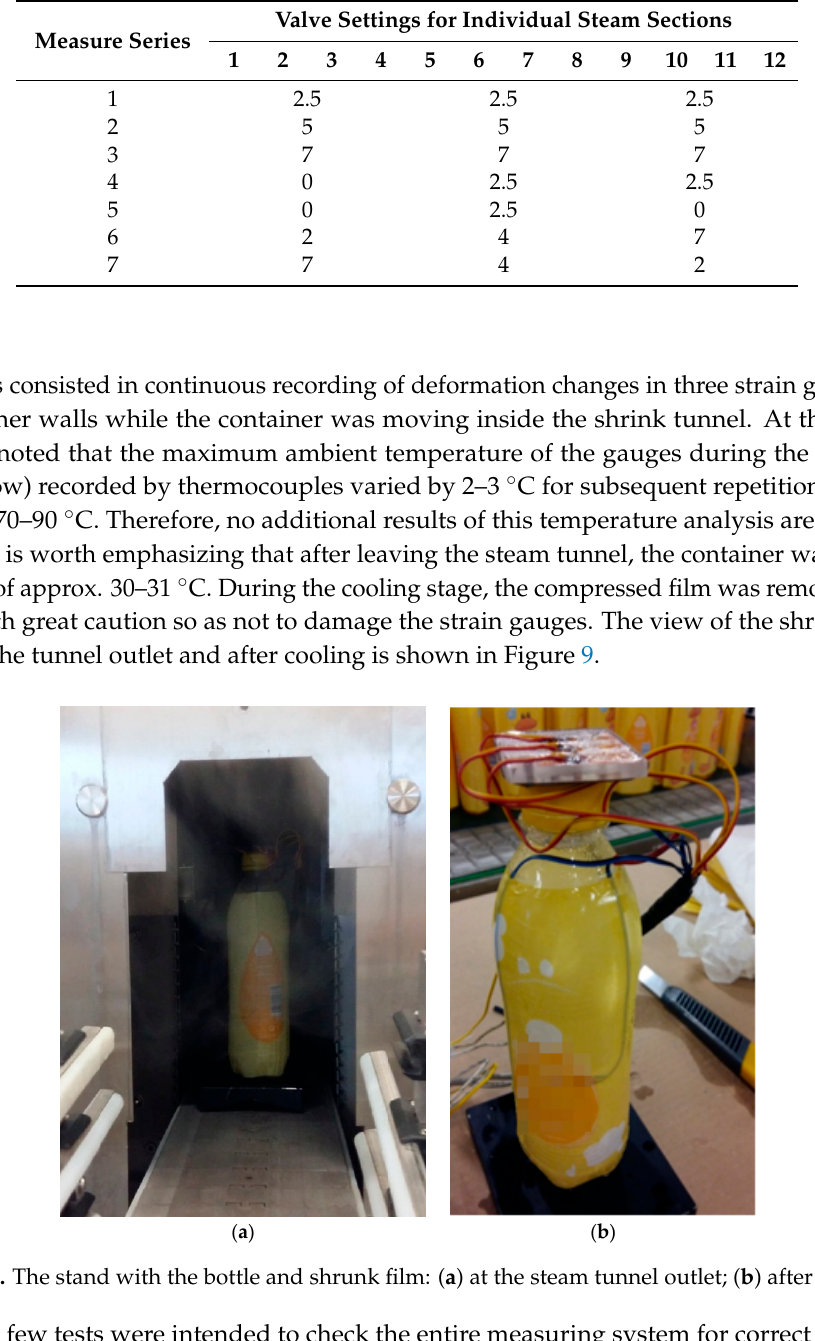
Table 1. Valve settings for individual steam sections in subsequent measurements.